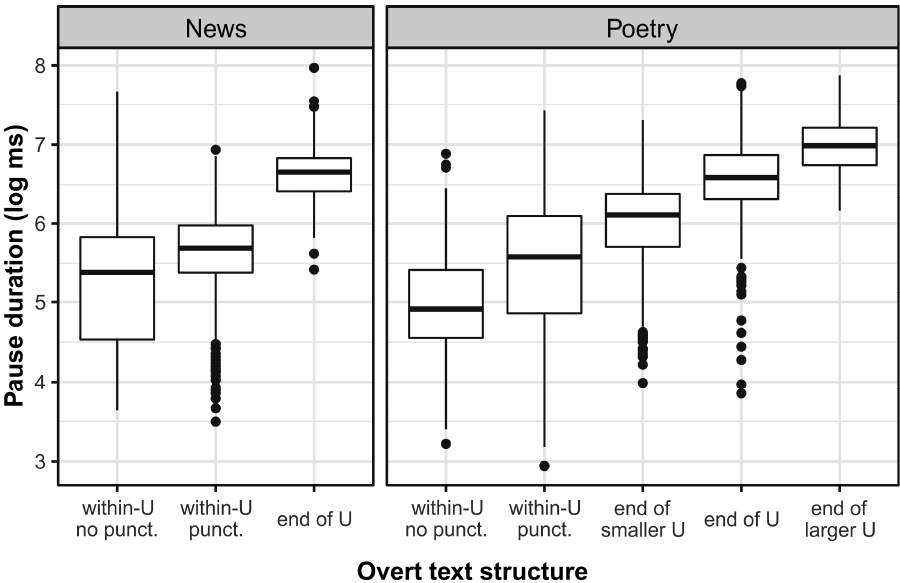
Figure 3. Boxplots of log pause duration in two genres as a function of overt text structure (U = unit; punct. = punctuation). For an explanation of levels, see Section 2.3.